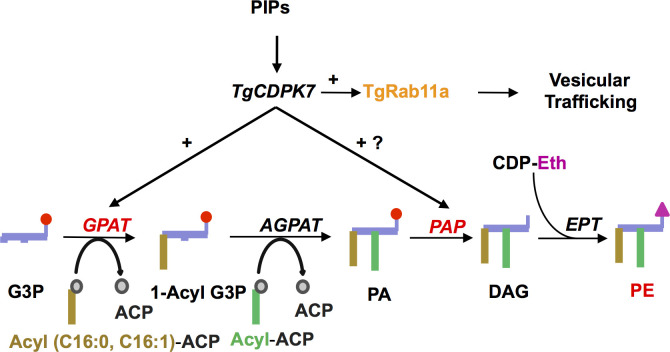
A model for TgCDPK7 signaling.TgCDPK7, which interacts with PIPs [8], targets trafficking of key proteins like GPI linked proteins like SAG1/3 via its ability to facilitate the phosphorylation of proteins like TgRab11a. It regulates PE metabolism in the parasite possibly via its ability to regulate enzymes involved in PL metabolism like GPAT and PAP and these events are critical for the division of T. gondii.